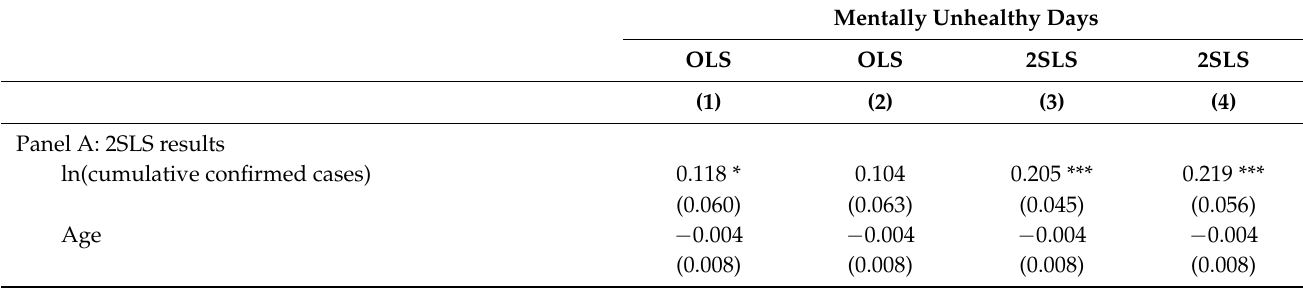
Table 2. Baseline